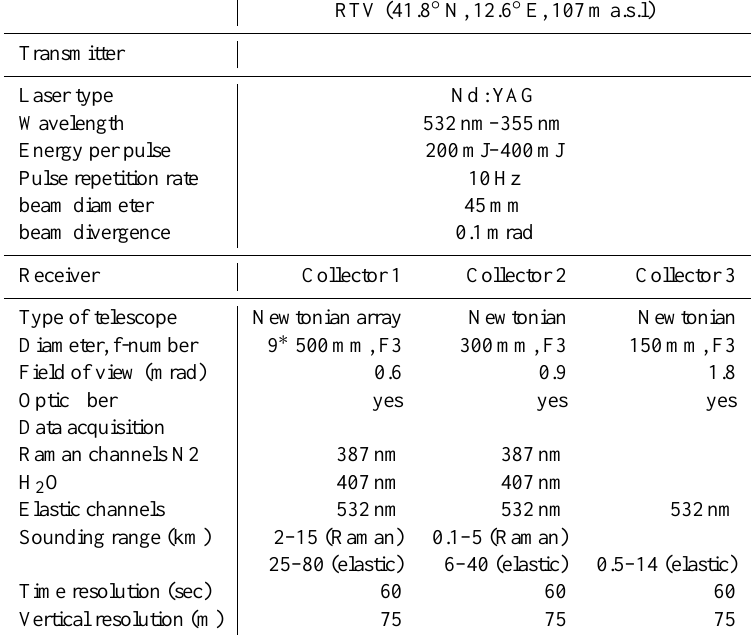
Table 1. Transmitter and receiver characteristics of the RTV lidar